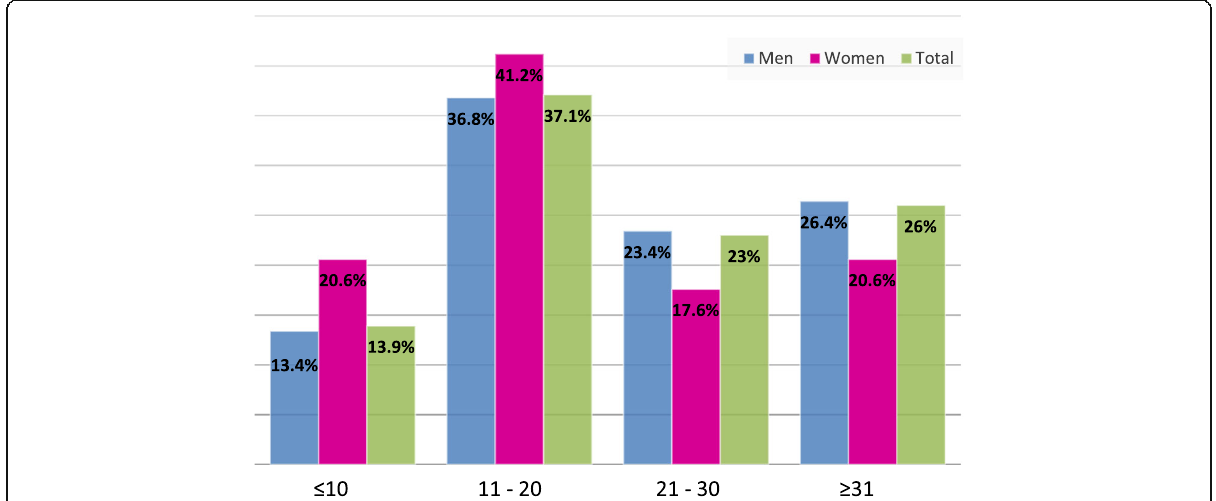
Fig. 1 Distribution of the number of cigarettes smoked per day by smokers attending the smoking cessation clinic of the University Hospital